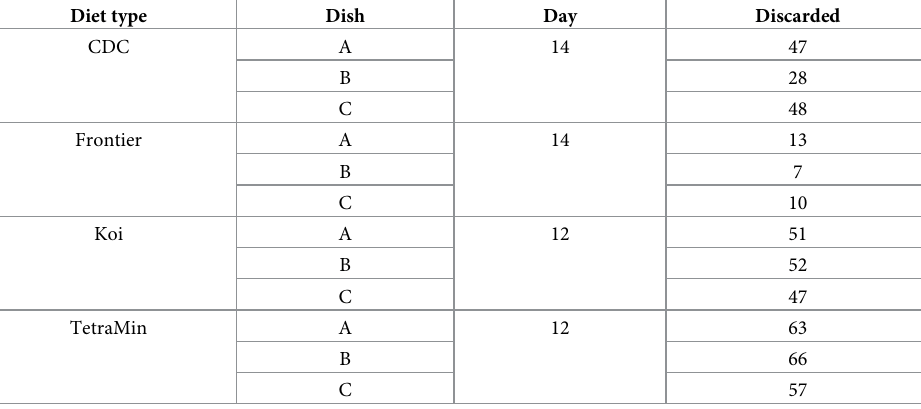
Table 1. The number of An . gambiae immatures discarded at the end of the trial at the lowest diet level, 8mg. Diet